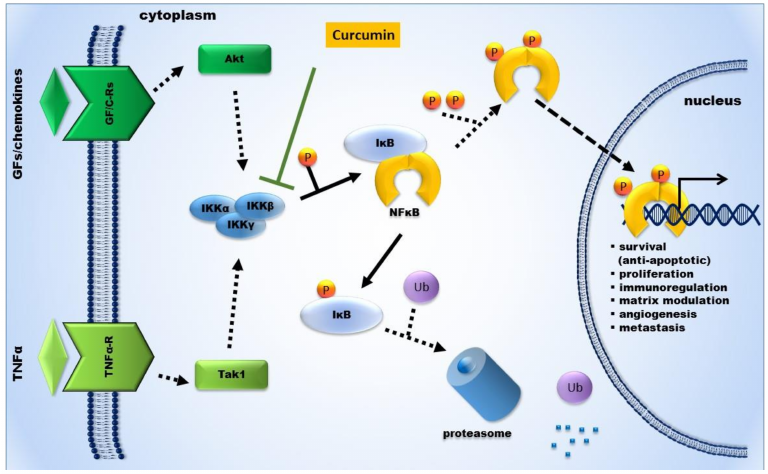
Figure 1. Schematic illustration of nuclear factor- κ B (NF κ B) signaling in the tumor environment. In resting cells, the NF κ B dimer is bound to its inhibitor (I κ B) and remains inactive in the cytoplasm. The activation cascade starts through binding of a ligand (TNF α = tumor necrosis factor α , TNF α R = TNF α -receptor, GF/CR = growth-factor/chemokine-receptor) to its receptor. Activation via TNF α occurs mainly through Tak1 (TGF β -activated kinase 1) and via growth factors and/or cytokines, mainly through Akt (v-akt murine thymoma viral oncogene homolog). This leads to activation of the IKK complex (inhibitor of κ B kinases; IKK α , β , γ ). By activating the IKK-complex, the inhibitor of κ B (I κ B) is phosphorylated and the NF κ B dimer is released and phosphorylated, which leads to translocation into the nucleus, where NF κ B binds to the respective DNA promotor regions, which leads to transcription of genes related to proliferation, immunoregulation, matrix modulation, angiogenesis, and formation of metastasis. Curcumin inhibits the activation of NF κ B by blocking the IKK-complex.